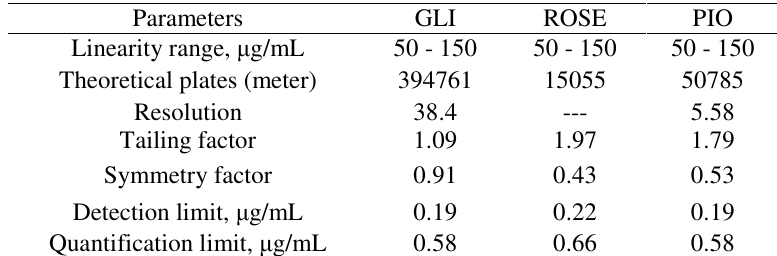
Table 3. System suitability parameter